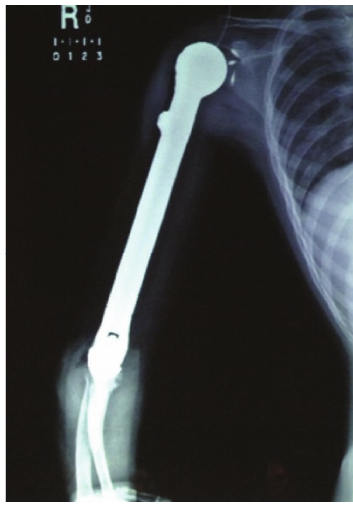
Figure 10: Postoperative anteroposterior humeral radiograph with implanted